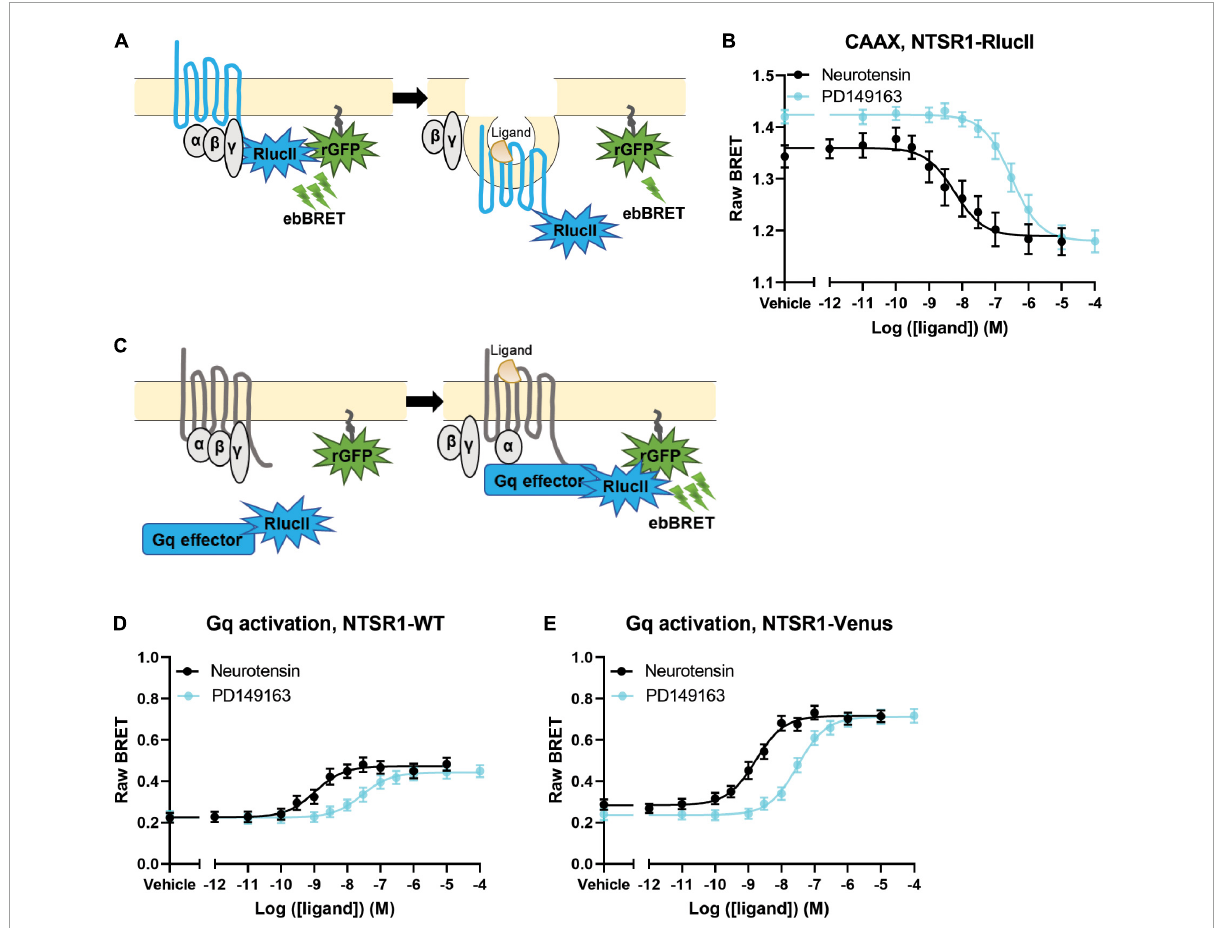
FIGURE1 Agonist profiling of NTSR1 in HEK-293 cells. (A) Scheme for BRET assay to measure receptor loss from the membrane shows receptor tagged with RlucII as the donor and rGFP-CAAX labeling the membrane as the acceptor. A decrease in BRET indicates receptor loss from the plasma membrane. (B) Dose-response curves for NTSR1-RlucII internalization, using NTSR1-RlucII (donor) and rGFP-CAAX (acceptor), profile two agonists, neurotensin and PD149163. (C) Scheme for BRET assay to measure agonist induced G protein activation shows Gq effector (Gq/11 binding domain of p63-RhoGEF fused to RlucII) tagged with RlucII as the donor and rGFP-CAAX labeling the membrane as the acceptor. An increase in BRET indicates G protein activation. (D,E) Gq protein activation BRET assay compares dose-response curves for neurotensin and PD149163 at the untagged NTSR1 (D) and at the Venus tagged (E) NTSR1. Data are expressed as raw BRET signal (Mean ± SEM) from five independent